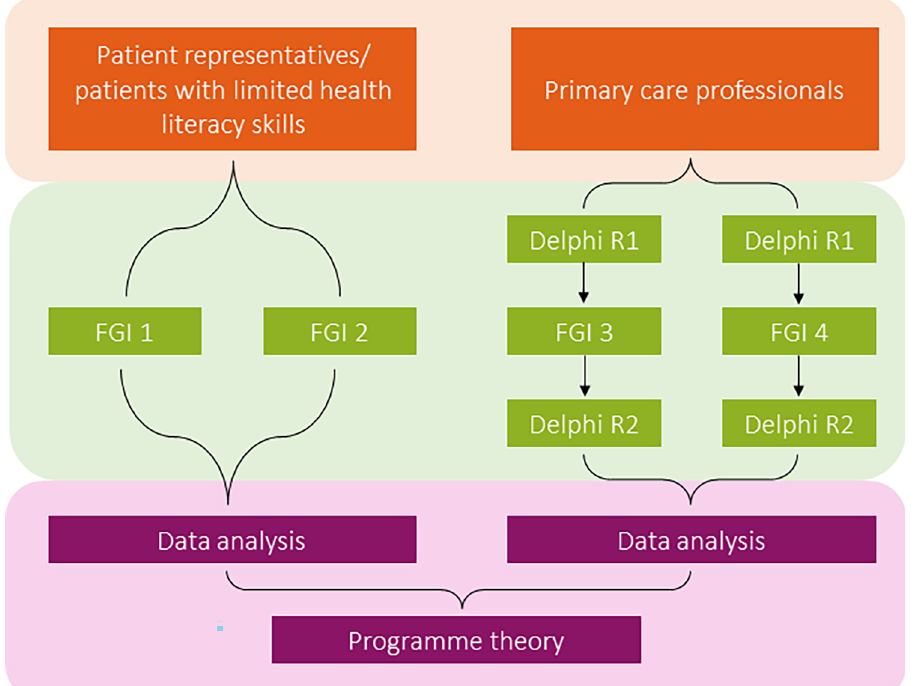
Fig 2. Overview of participants, data collection, and data